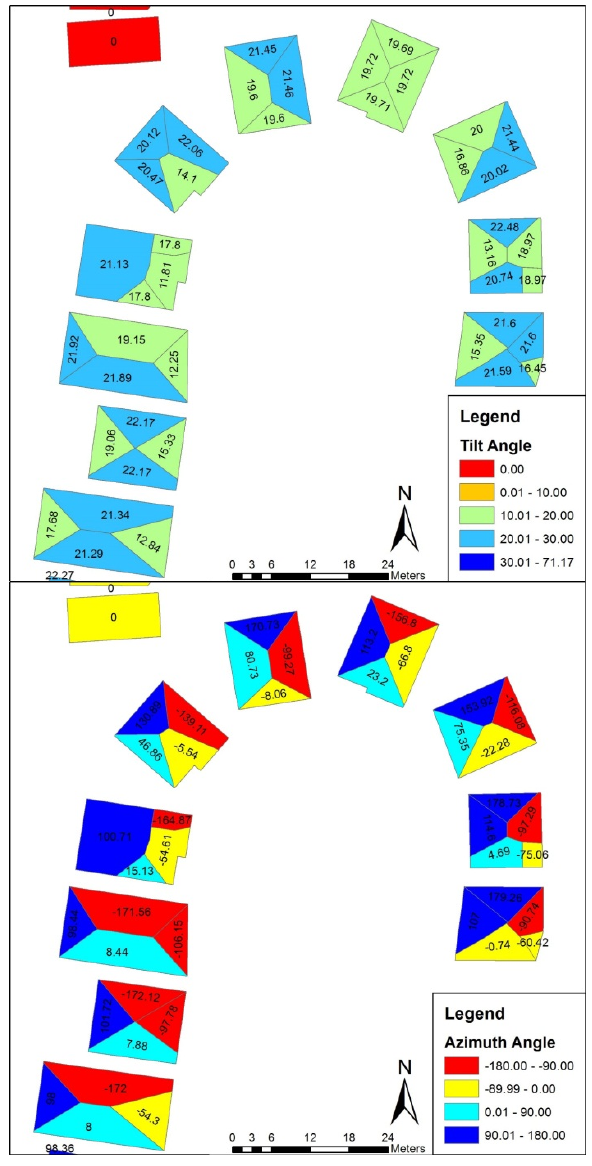
Figure 4. Map showing the tilt and azimuth angles generated for a sample area (azimuth angle adopts the ASHRAE tradition where 0° to south, 180° to north, negative to east, and positive to west). The total irradiance of each surface is the sum of three components: direct, diffuse and ground-reflected irradiances. Each of the components is a function of its normal and horizontal irradiance and the angle of incidence to the surface. These components are calculated separately. Et, b “ Eb cos θ r 14